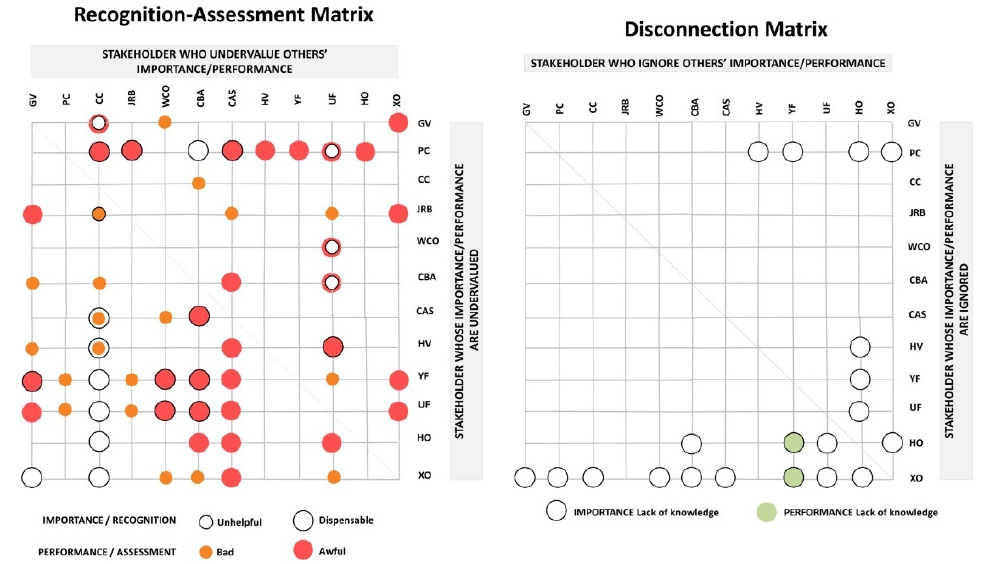
Figure 11. Recognition-assessment and disconnection matrices. Note: government officials (GV, PC, and CC, that includes the 8 city councils); water managers (JRB and WCO); agricultural sector (CBA, CAS, HV, YF, UF); tourism sector (HO); environmental sector (XO).